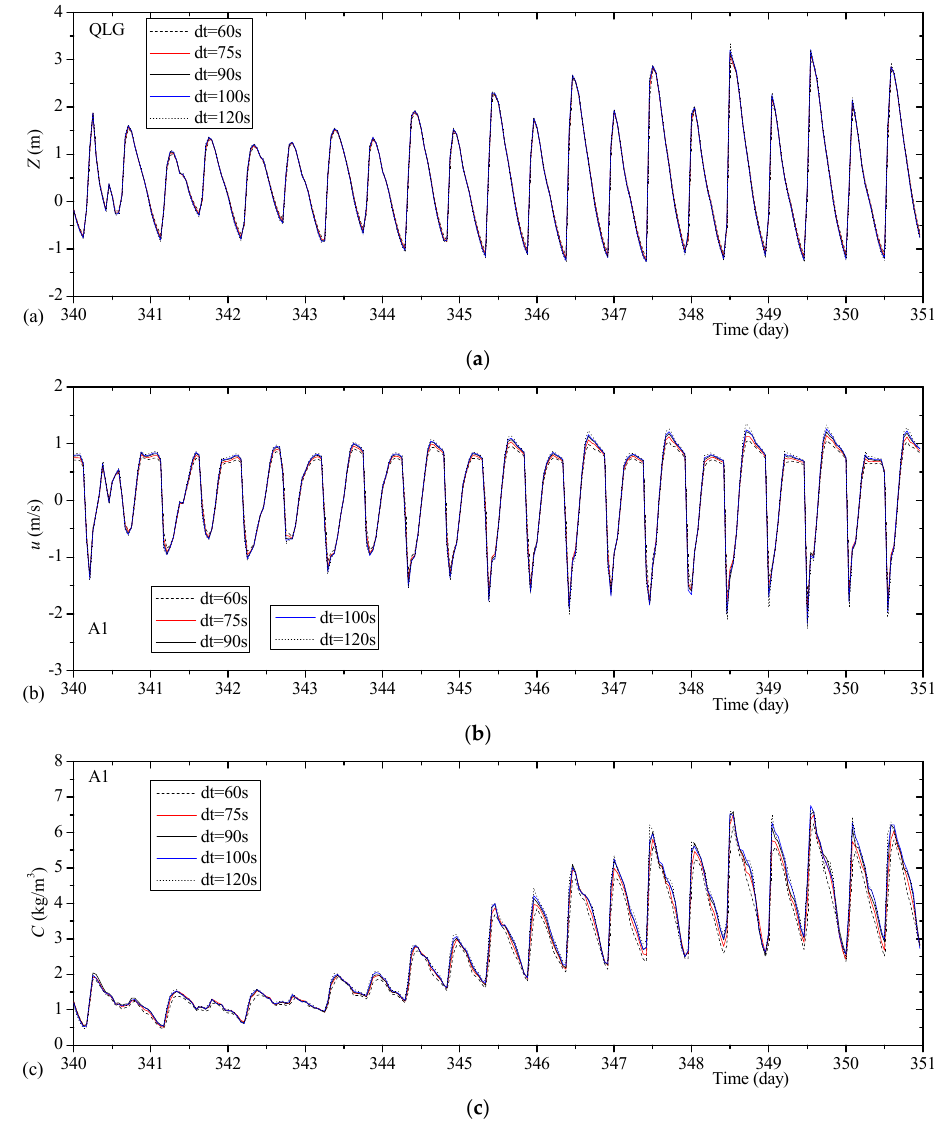
Figure 8. Comparisons of the simulated histories and field data. ( a ) Tide-level histories at Station Qinglonggang (QLG), ( b ) velocity histories at Survey Point A1, and ( c ) sediment concentration histories at Survey Point A1.